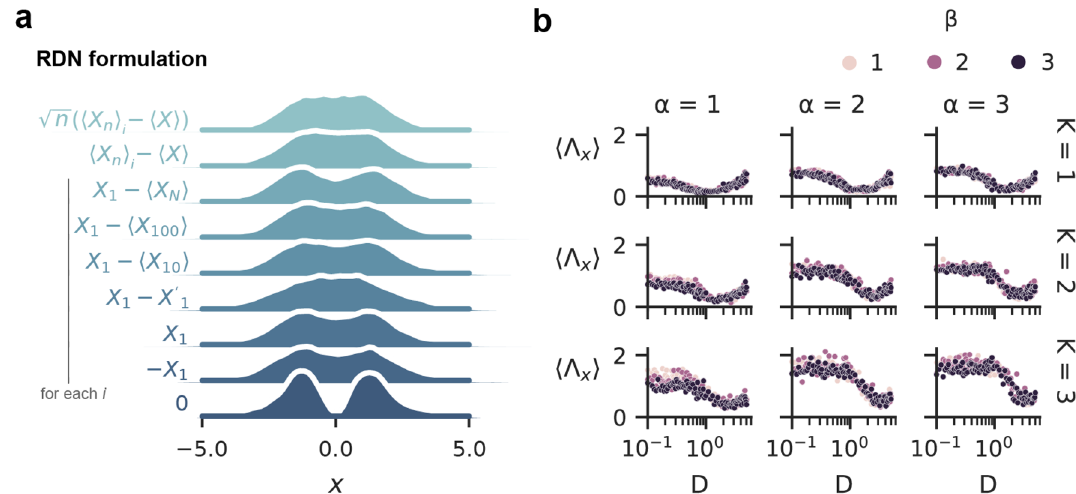
Figure 5. Assessing the robustness of the RDN. ( a ) Different RDN formulations produce similar results as long as each agent gets a different sample ( D See Table 1 for equation explanations. ( b ) The scatter plots in each panel show the polarized peak distance (cid:31) x averaged over sample size 1...50. Columns indicate different values of α . Rows indicate different values of K . Colors indicate different values of β . Other parameters were N